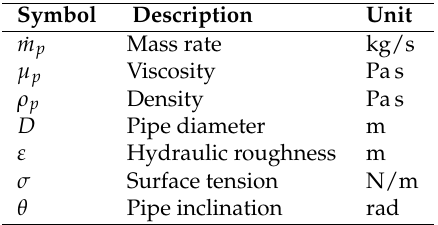
Table 1. Input to the flow model. The index p refers to phase, where g is gas and l is liquid.